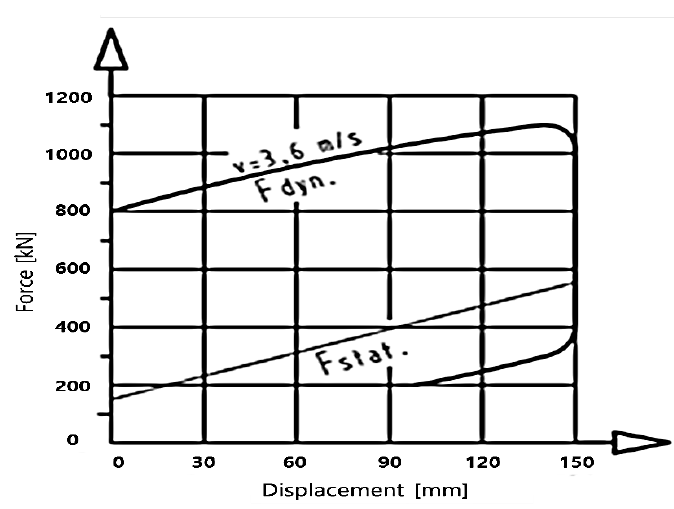
Figure 6. Internal shape of a hydrostatic buffer [12].